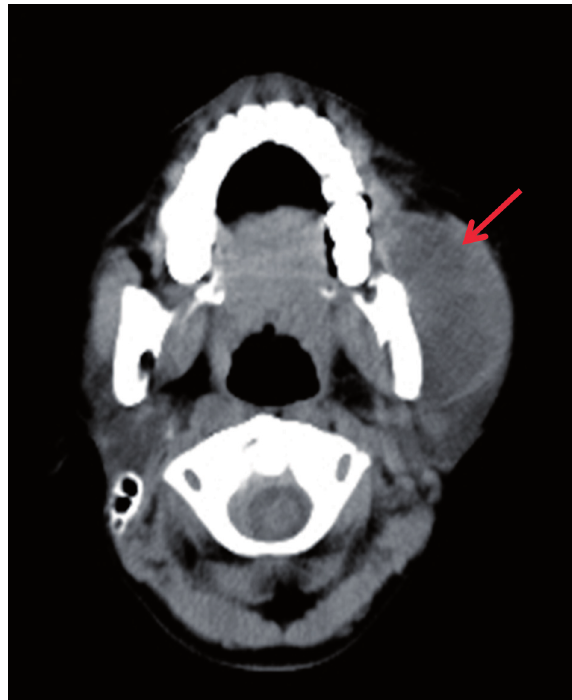
Figure 2: CT scan neck showing parotid